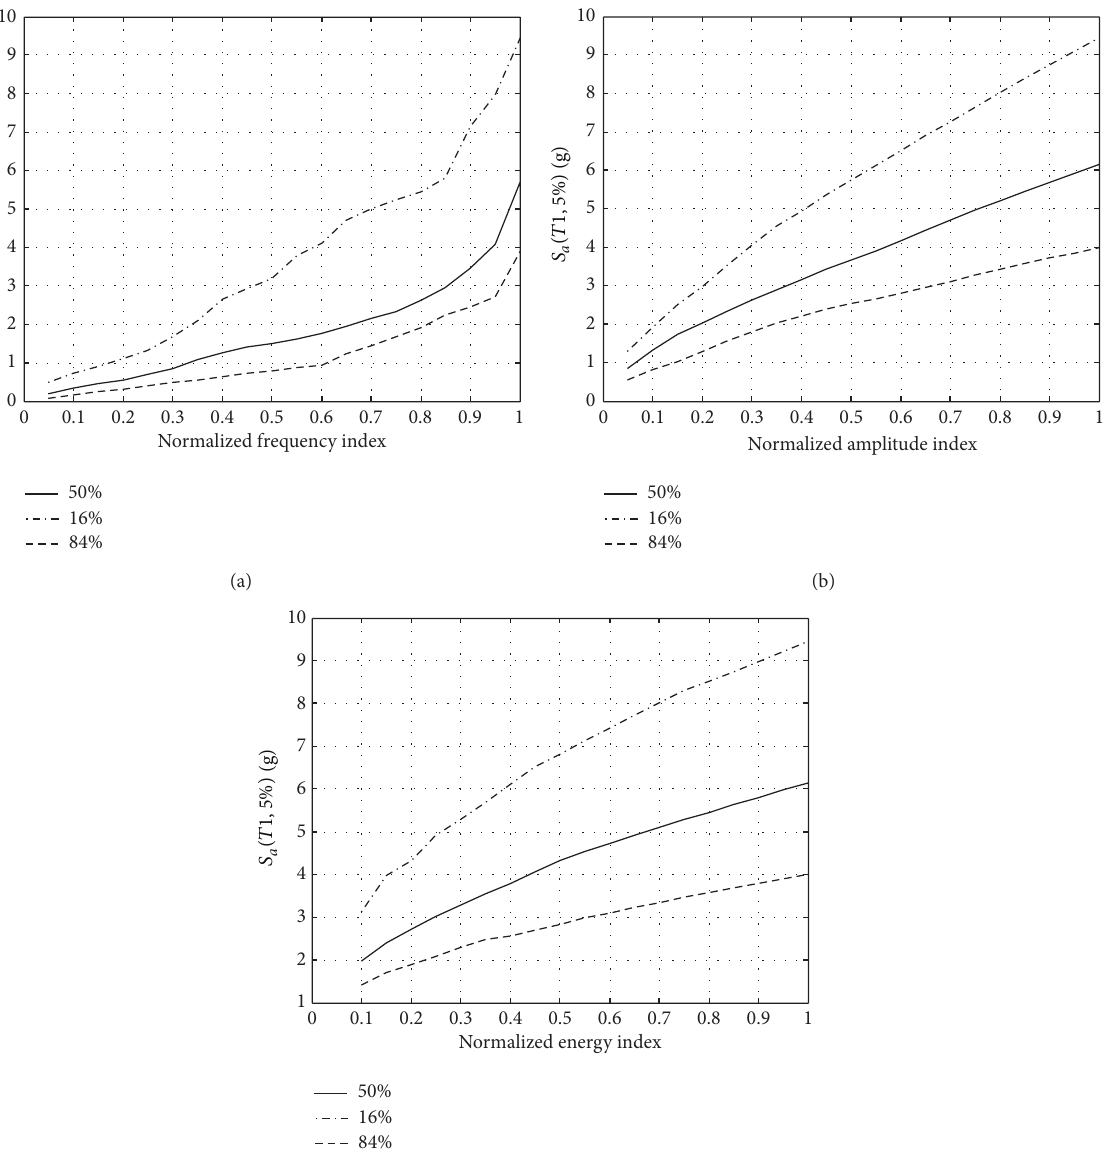
Figure 12: IDA curves for feature indexes. (a) Frequency, (b) amplitude, and (c)